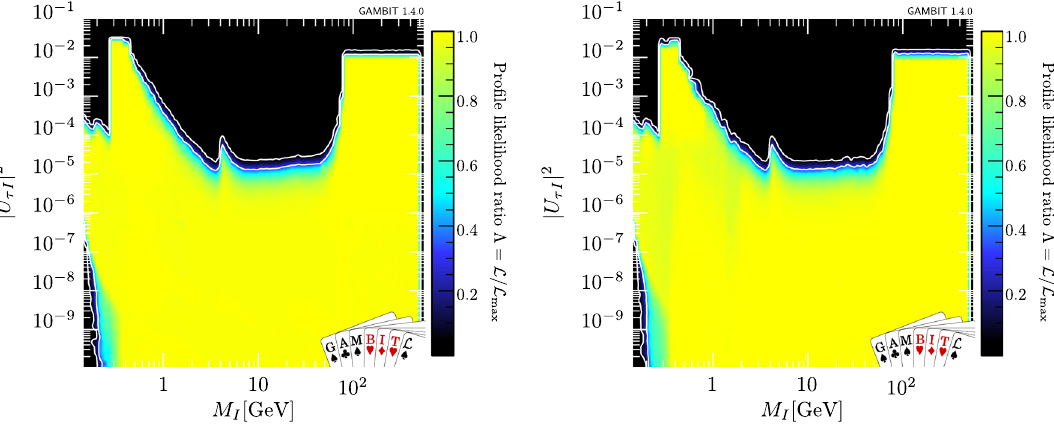
Fig. 3 Profile likelihood in M I vs U 2 τ plane for normal (left) and inverted hierarchy (right). Tables with the 90% and 95% CLs for both hierarchies I can be found in Zenodo [186]